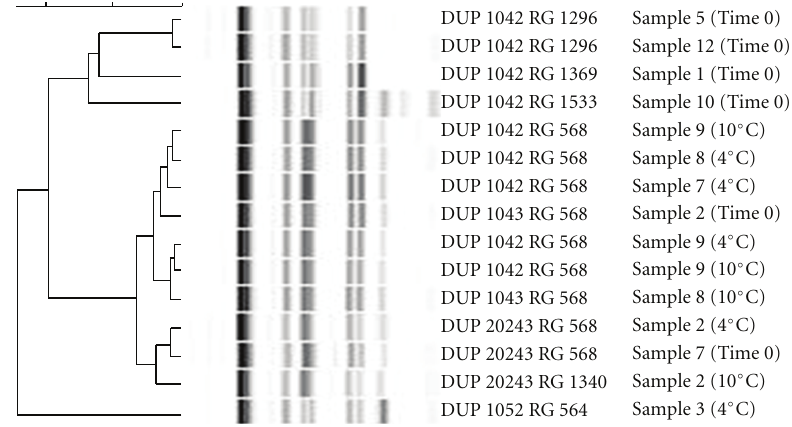
Figure 2: Phylogenetic distances between the various isolated L. monocytogenes